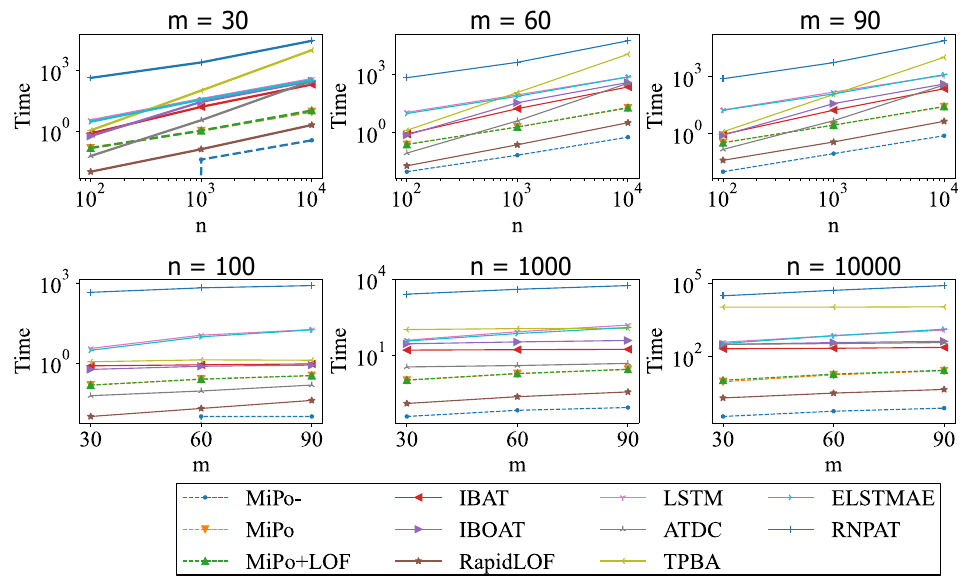
Figure 11. Running time (s) of MiPo-, MiPo, MiPo+LOF, and baseline trajectory outlier detection methods varying the number of the trajectories n and the trajectory length m . The proposed MiPo was linear to n and m . Additionally, MiPo+LOF had much lower time complexity than accuracy- competitive baselines, such as IBAT.